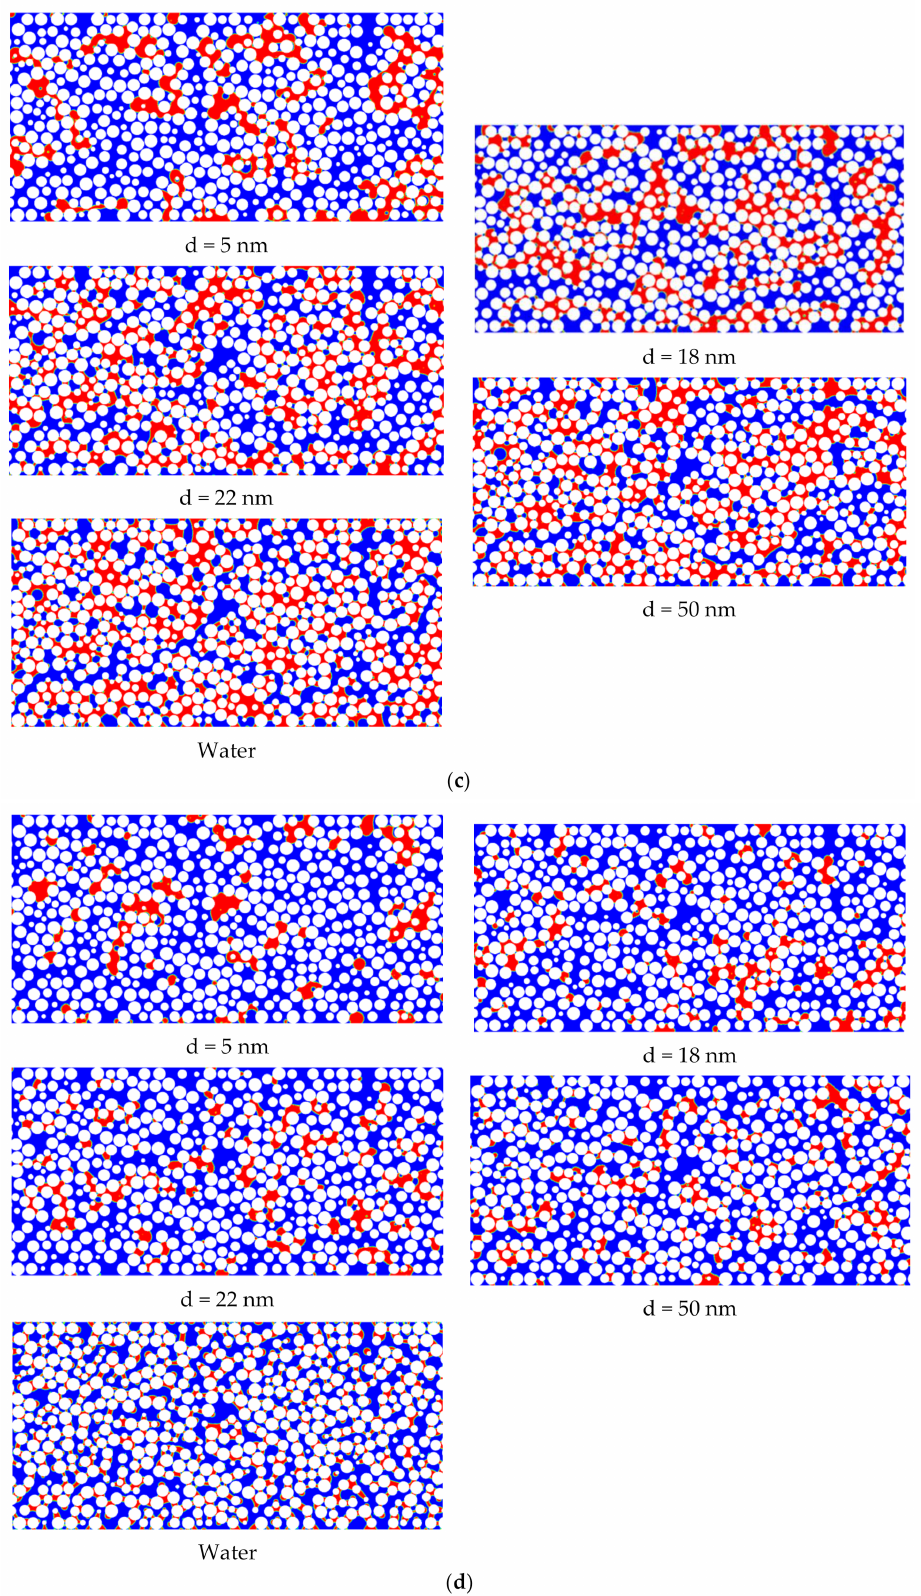
Figure 10. Distribution of oil (blue) and displacing fluid (red) at different particle sizes in the nanosuspension at different water saturation of the porous medium. Water saturation: 0% ( a ); 30% ( b ); 50% ( c ); 80% ( d